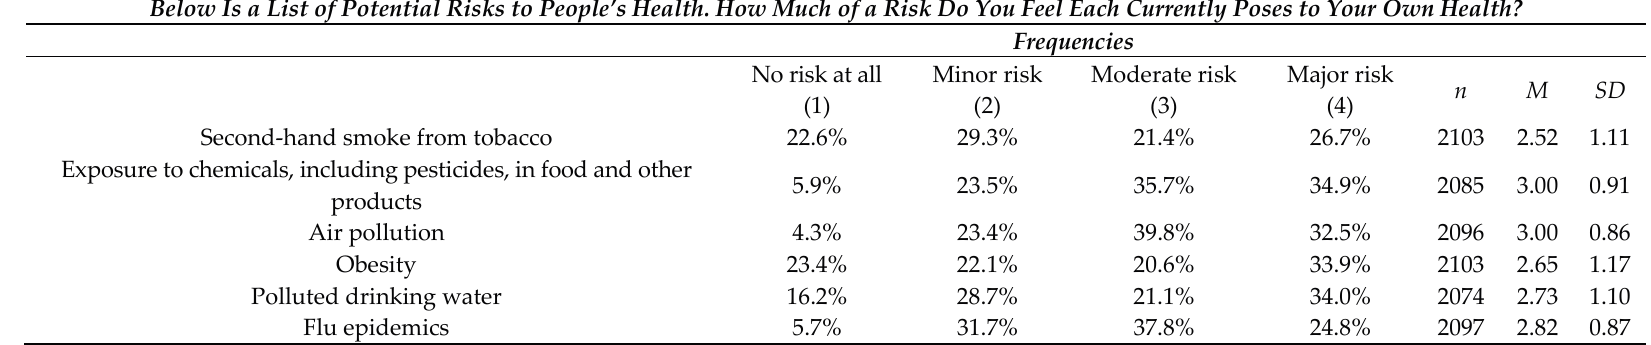
Table S3. Non-climate health risk perceptions: Factor score variables ( n =